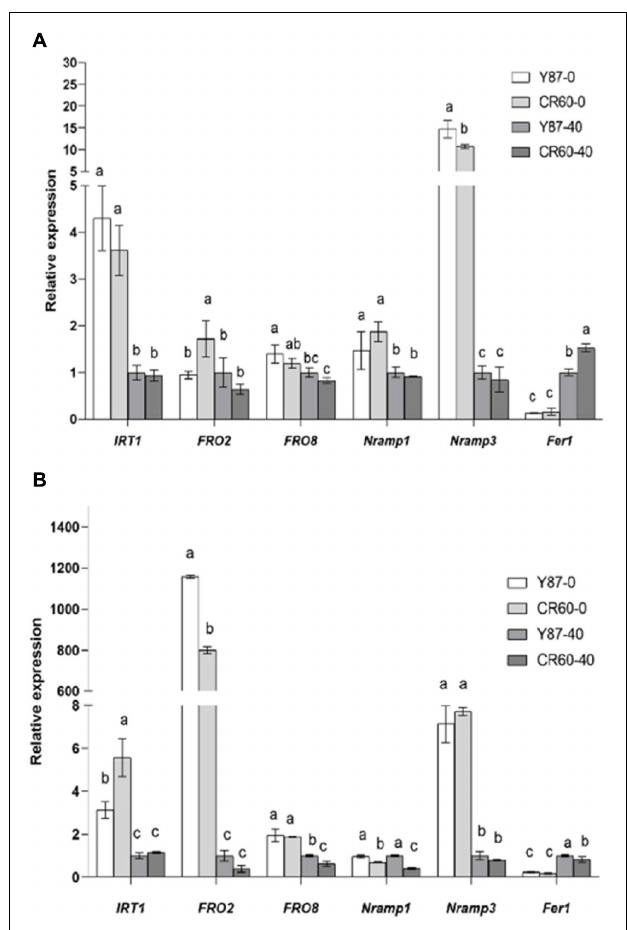
FIGURE 5 | Relative expression of genes associated with iron uptake and homeostasis in leaves (A) and roots (B) of Y87 and CR60. The plants were grown in 1/2 Hoagland nutrient solutions containing 0 or 40 µ M Fe (III)-EDTA for 21 days. The first fully expanded apical leaves or whole roots were harvested for RNA isolation and RT-PCR analysis. The data are expressed as means ± SD ( n = 6). Different letters indicate significant differences at P < 0.05 (Student’s t